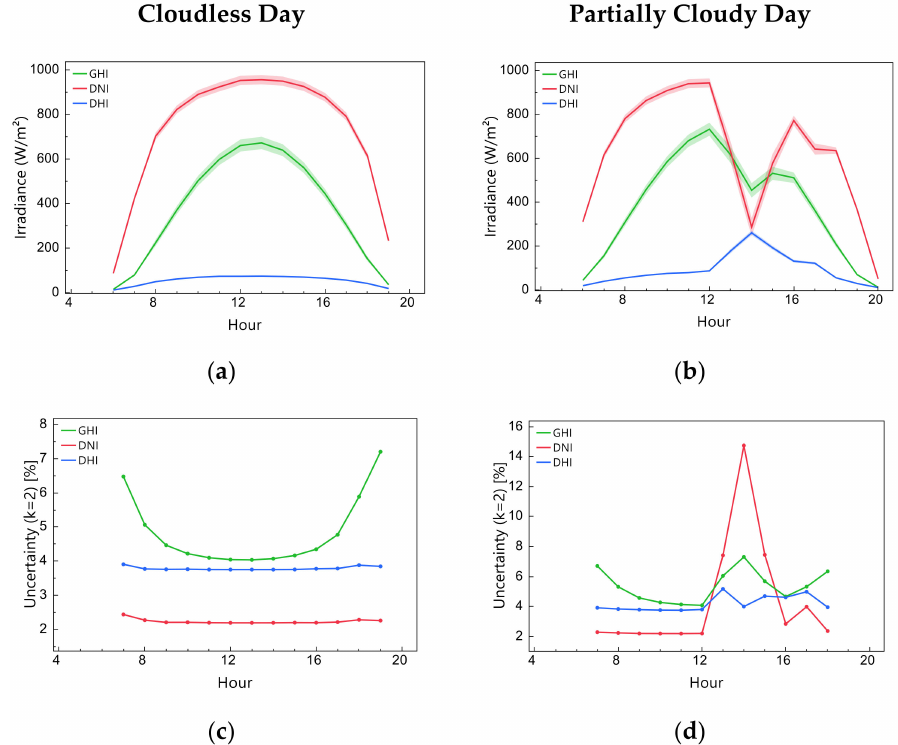
Figure 3. Uncertainty of the hourly GHI, DHI, and DNI measurements performed onsite from two example days in April 2019. A cloudless day is shown in ( a ) and ( c ) and a partially cloudy day is shown in ( b ) and ( d ). The top row shows the absolute uncertainty (in W / m 2 ) as shaded bands around the measured value. The bottom row shows the uncertainty in